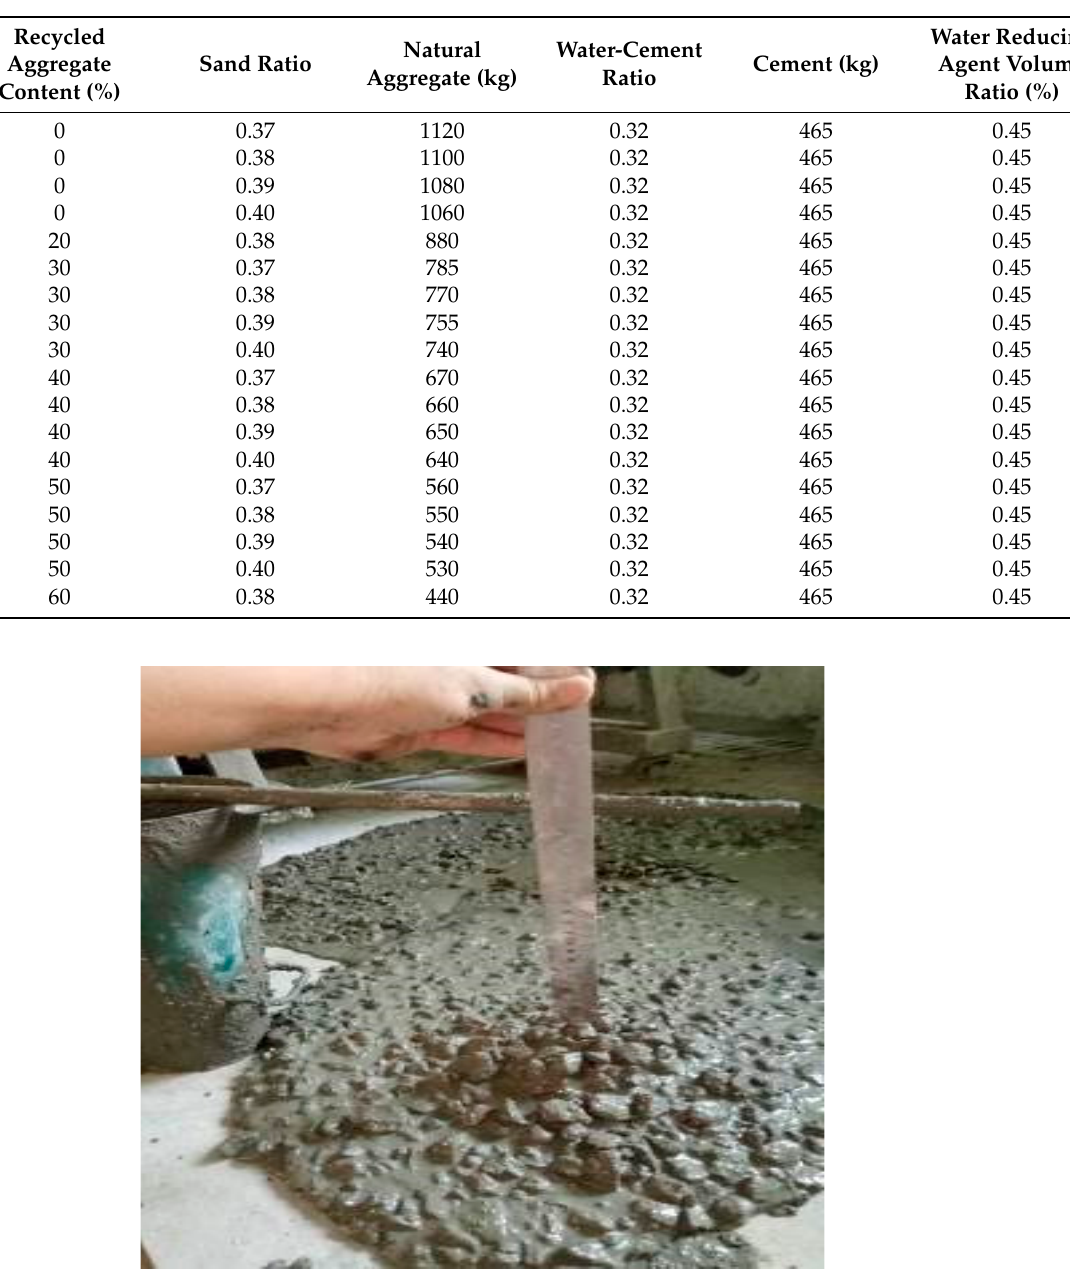
Table 3. Mix proportion of the concrete.